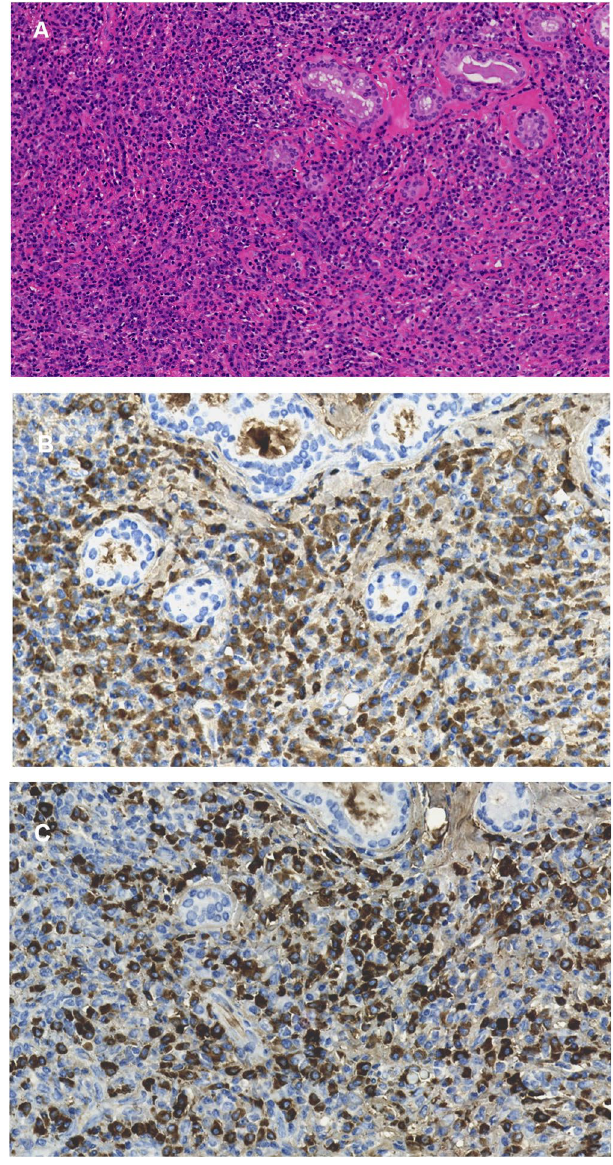
Figure 1. H&E and immunohistochemical staining of nasal mucosa specimens of IgG4-RD patients complicated with CRS. A: H&E staining of nasal mucosa specimens of IgG4-RD patients complicated with CRS showed dense lymphocyte infiltration (( A ) original magnification 200×). B&C: IgG (( B ) original magnification 400×) and IgG4 (( C ) original magnification 400×) immunohistochemical staining of nasal mucosa specimens of IgG4-RD patients complicated with